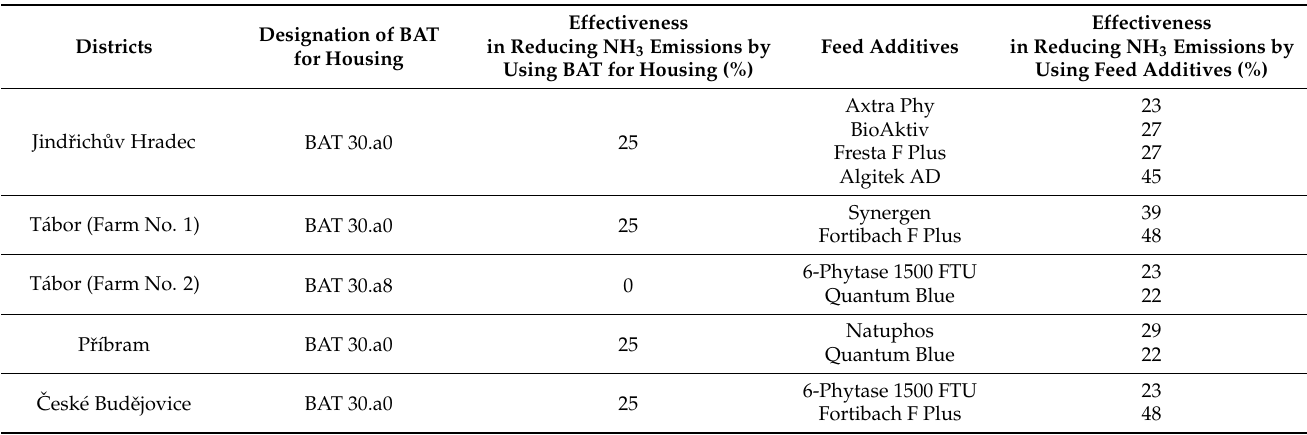
Table 1. BAT applications in selected